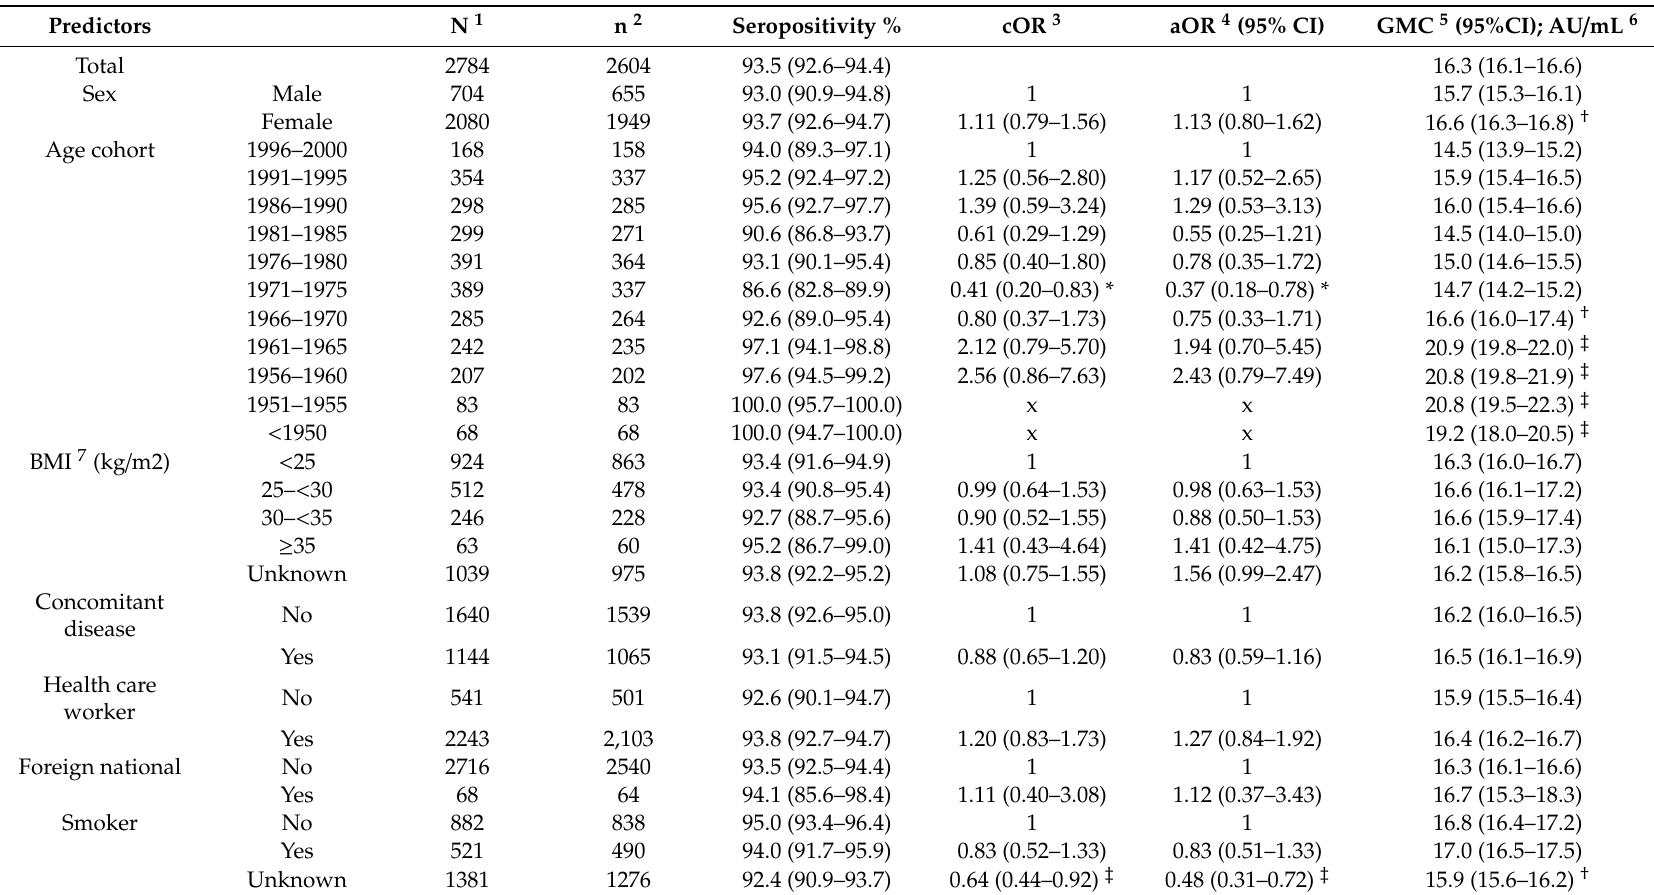
Table 2. Persistence of seropositivity against measles and geometric mean concentrations (GMCs) of measles antibodies, crude and mutually adjusted odds ratios (cORs, aORs) including the 95% confidence